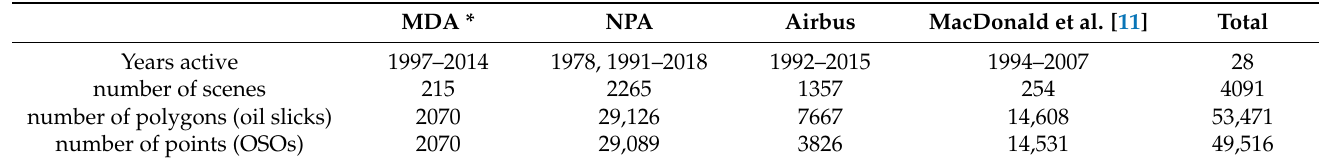
Table 2. Data acquired from vendors and MacDonald et al. [11], including all classifications.